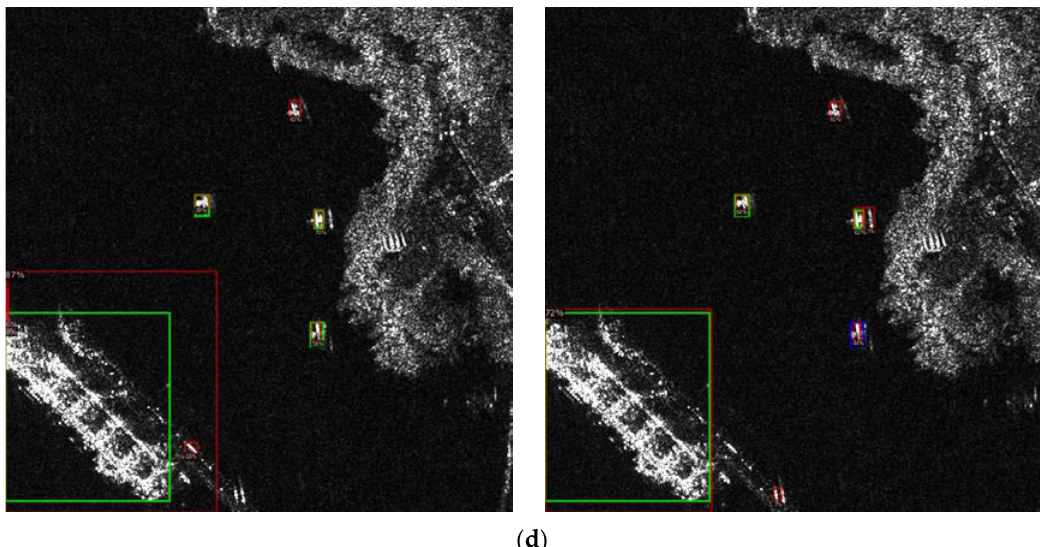
Figure 17. Comparison of detection results between traditional random cropping algorithm (left column in each panel) and the proposed method (right column in each panel) on medium and large targets. The green boxes represent the true bounding boxes of the targets that were successfully detected. The blue boxes indicate the true bounding boxes of the targets that were not successfully detected. The red boxes represent the model prediction results, and the number on the red box represents the model’s confidence in this prediction result. ( a ) Example 5; ( b ) Example 6; (c) Example 7; ( d ) Example 8.